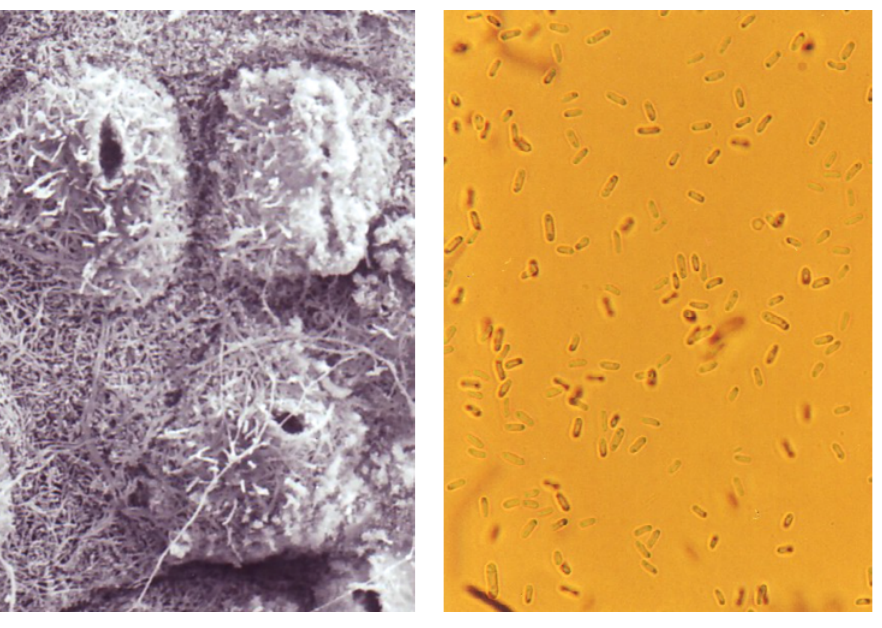
Fig. 3. Pycnidia of Phoma negriana (SEM), 200 x magnification. Phot. M. Wróbel.